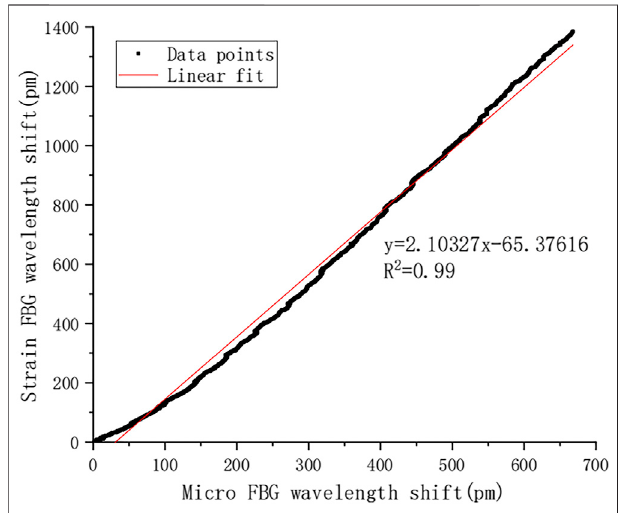
FIGURE 4 | Linear fi t of wavelength change between the micro-FBG sensor and the FBG strain